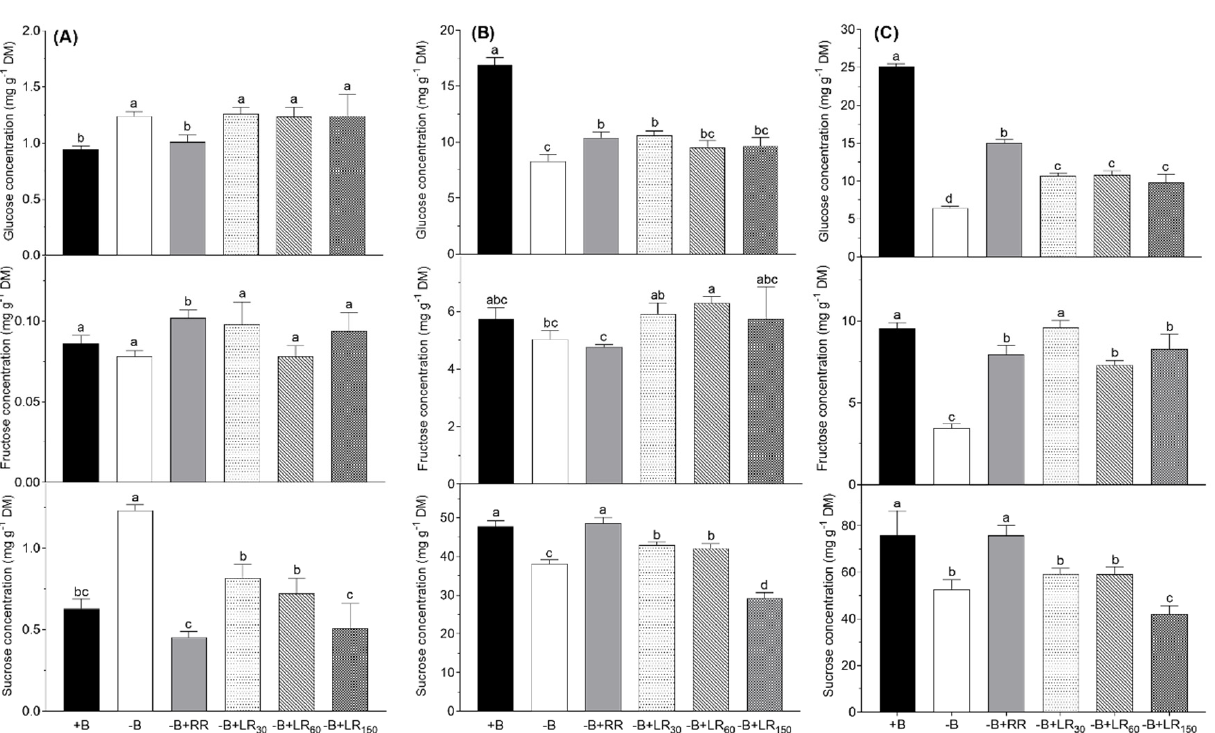
Figure 5. Glucose, fructose and sucrose concentrations in the roots ( A ), mature leaves ( B ) and young leaves ( C ) of Brassica napus grown in nutrient solution under different B treatments for 42 days. +B, 25 µ M B in NS; − B, 0.25 µ M B in NS; − B+RR, 0.25 µ M B in NS for the first two weeks and then 25 µ M B for the latter two weeks; − B+LR 30 , 0.25 µM B in NS and foliar-applied 30 mM B at two weeks; − B+LR 60 , 0.25 µ M B in NS and foliar-applied 60 mM B at two weeks; − B+LR 150 , 0.25 µ M B in NS and foliar-applied 150 mM B at two weeks. The data ± SE are means of five independent pot replicates. Different letters on bars indicate significant differences between treatments (ANOVA with Duncan’s multiple range test p ≤ 0.05).